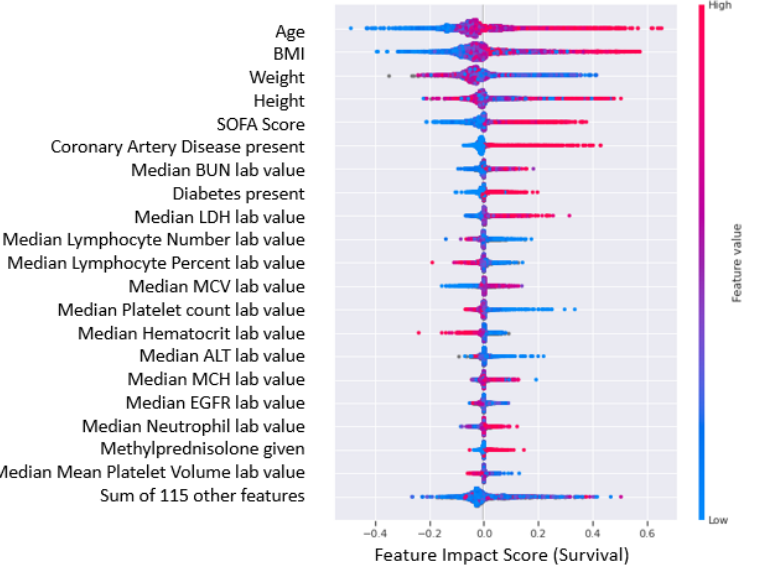
Figure 7. Top 20 most impactful features for COVID-19 survival predictive model. The red data points indicate higher values for the particular feature, while blue data points indicate lower values for the particular feature. A higher feature impact score indicates a higher contribution to a “no survival from COVID-19” prediction, while a lower feature impact score indicates a higher contribution to a “survival from COVID - 19” prediction value.